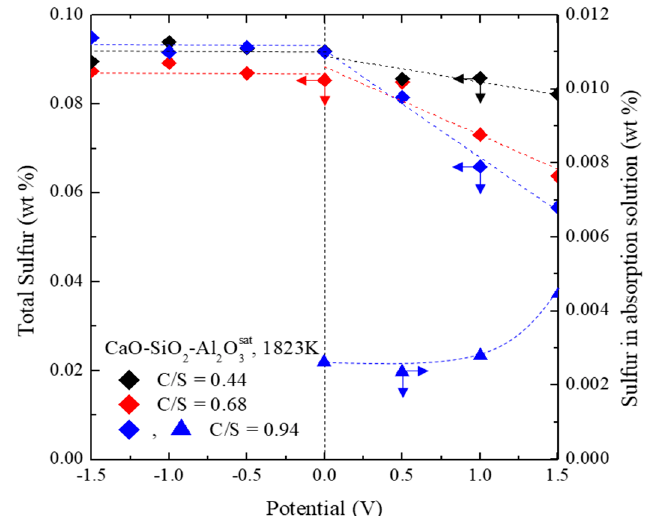
Figure 3. Residual sulfur concentration and sulfur concentration in the absorption solution after anodic electro-desulfurization as functions of the electrical potential.